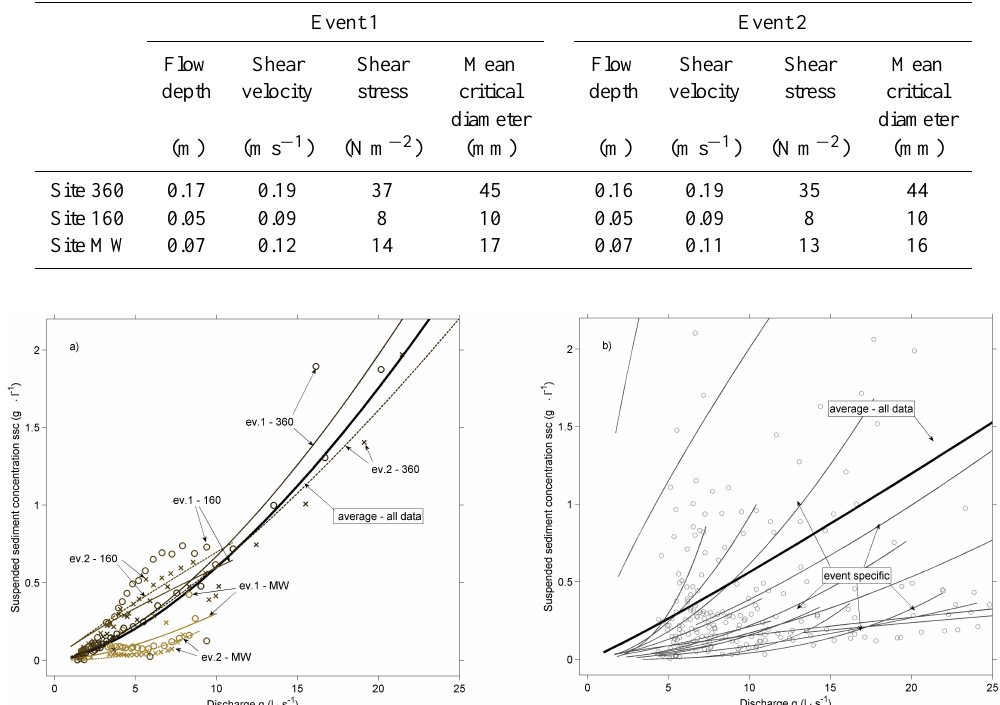
Table 2. Estimated hydraulic conditions at maximum discharge at the measurement sites and associated critical mean sediment diameter.